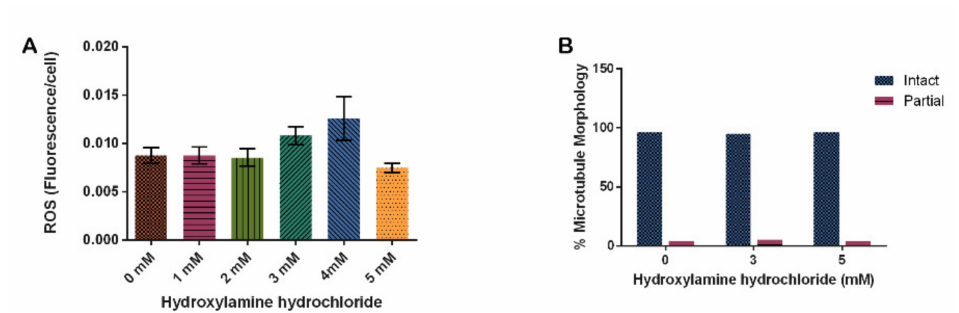
Figure 5. Effect of hydroxylamine hydrochloride on in vivo reactive oxygen species production and microtubule stability in D. discoideum. ( A ) HA increases ROS at 3 and 4 mM but this is not significant ( N = 5, p = 0.3120). ( B ) HA has no effect on microtubule morphology in D. discoideum (n > 50, p = 0.9495). Columns are averages and error bars represent the standard